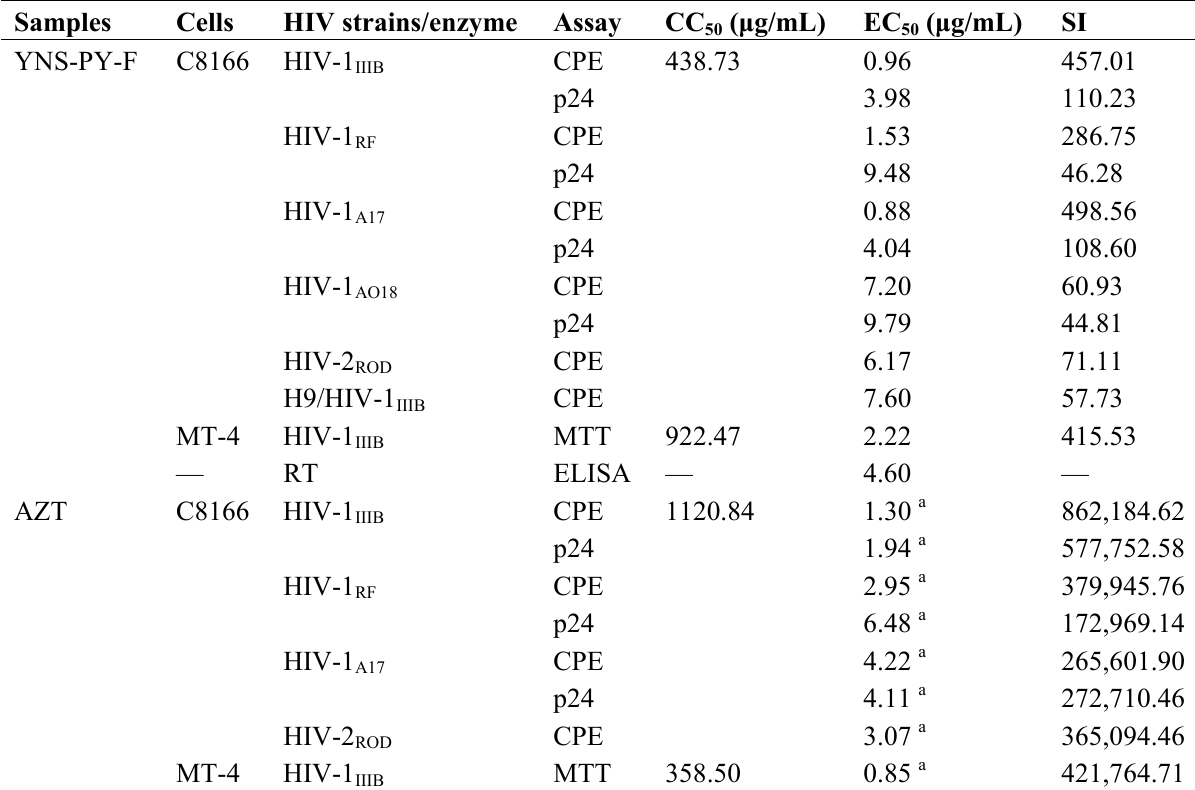
Table 1. Cytotoxities and anti-HIV activities of YNS-PY-F. CC inhibits 50% of cell viability. EC production or enzyme